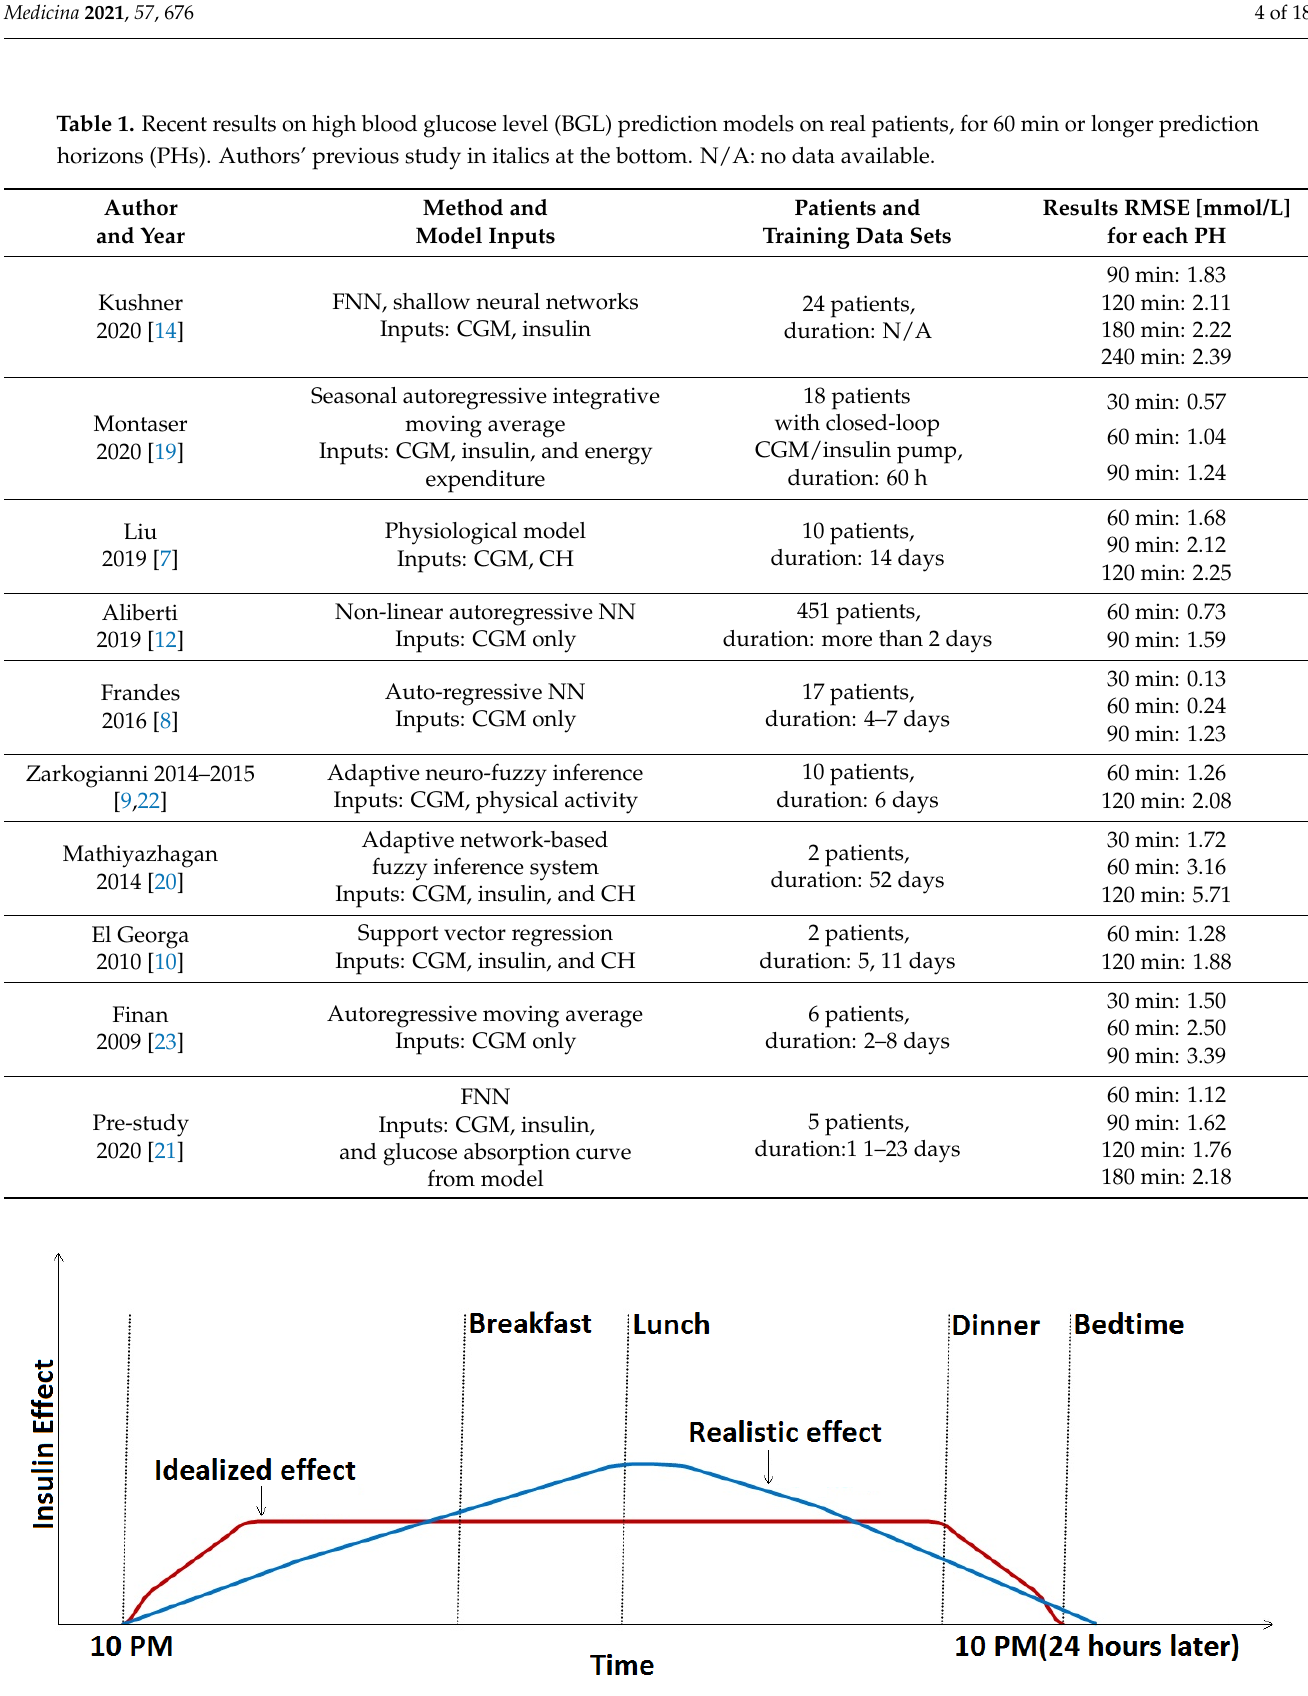
Figure 1. Ideal and realistic basal insulin effect in the function of time.